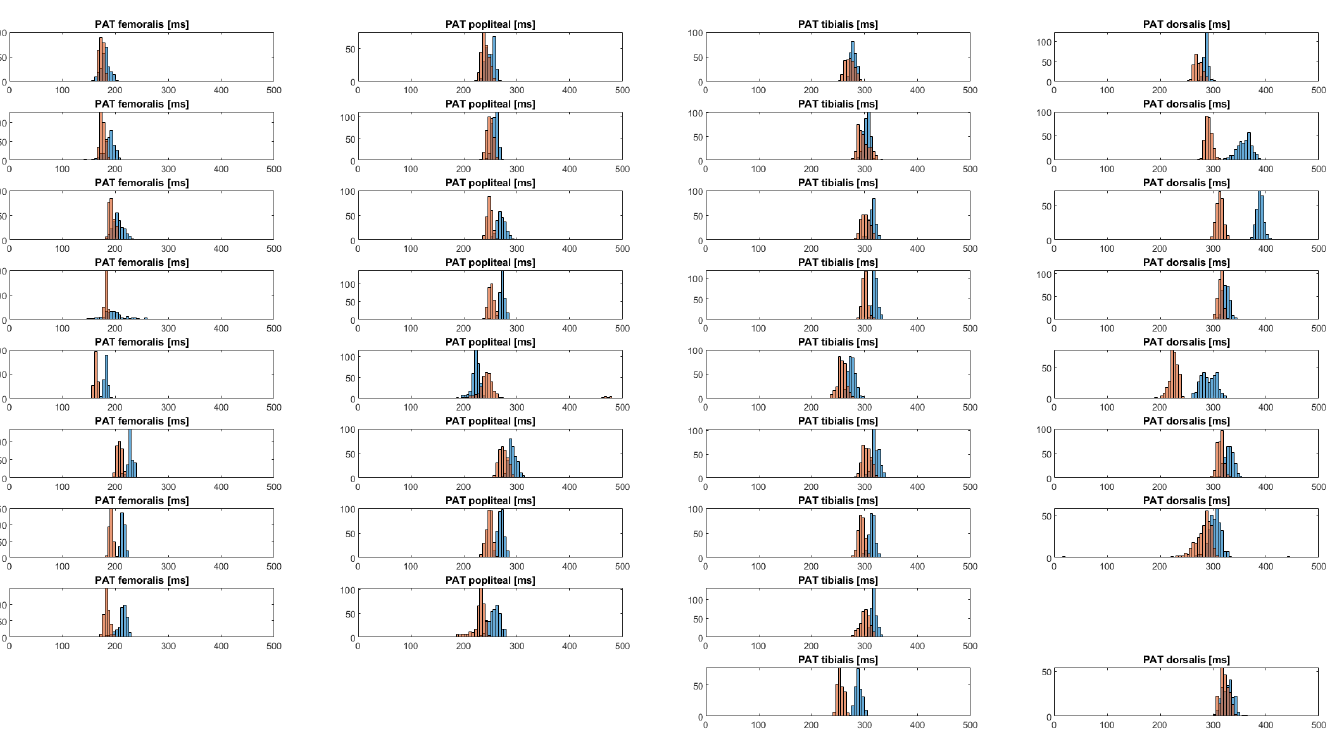
Figure 3: An indication of the difference between the tonometer (orange) and the bioimpedance (blue) for the estimated pulse arrival time (PAT) in milliseconds displayed in a distribution. The PAT was estimated in the a. femoralis, a. popliteal, a. tibialis posterior and a. dorsalis pedis in nine healthy participants during a five minute measurement. Each column represents an artery, and each row represents a participant. The a. dorsalis from one subject and a. femoralis and a. popliteal from another were removed from the data due to poor signal quality hampering pulse detection from either tonometer or bioimpedance signals.